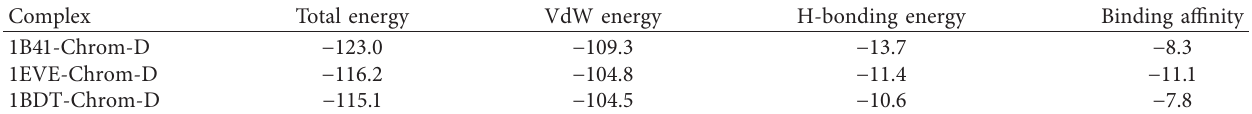
Table 6: Docking energies (in kcal.mol − 1 ) of the compound Chrom-D against AChE enzymes. Complex Total energy VdW energy H-bonding energy Binding affinity